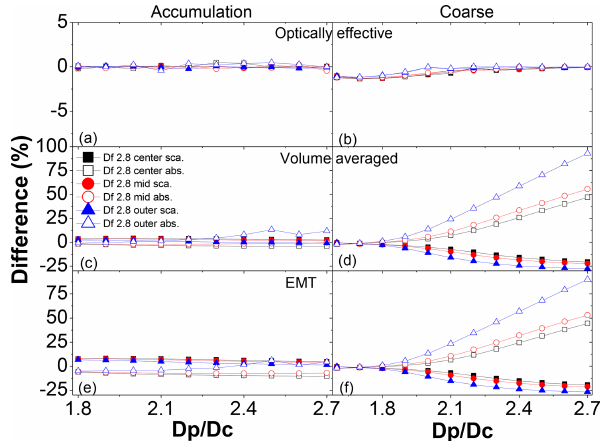
Figure 6. The retrieved optically effective aerosol complex refrac- tive indices of BC aggregates coated by sulfate (BC fractal dimen- sion of 2.8) with a different shell / core ratio ( D p /D c ) and parti- cle size distribution for the accumulation ( a , e ) and coarse ( b , f ) modes, respectively. The estimated refractive indices given by the volume-weighted average method ( c , g ) and Bruggeman effective medium theory ( d , h ) are considered for the coarse mode. The real and imaginary parts correspond to panels a , b , c and d , and e , f , g and h , respectively. The geometric standard deviations ( σ g ) for ap- plied lognormal distribution are 1.59 and 2.0 for accumulation and coarse aerosols,